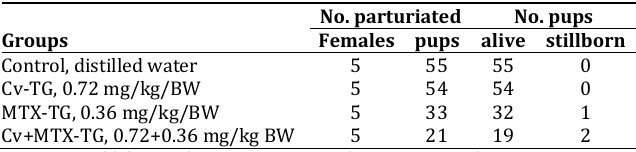
Table 4. The number of alive, stillbirth body weight of parturated pups of carvedilol, methotrexate alone and in combination Table 5. The effect of cavedilol alone and combined with methotrexate on